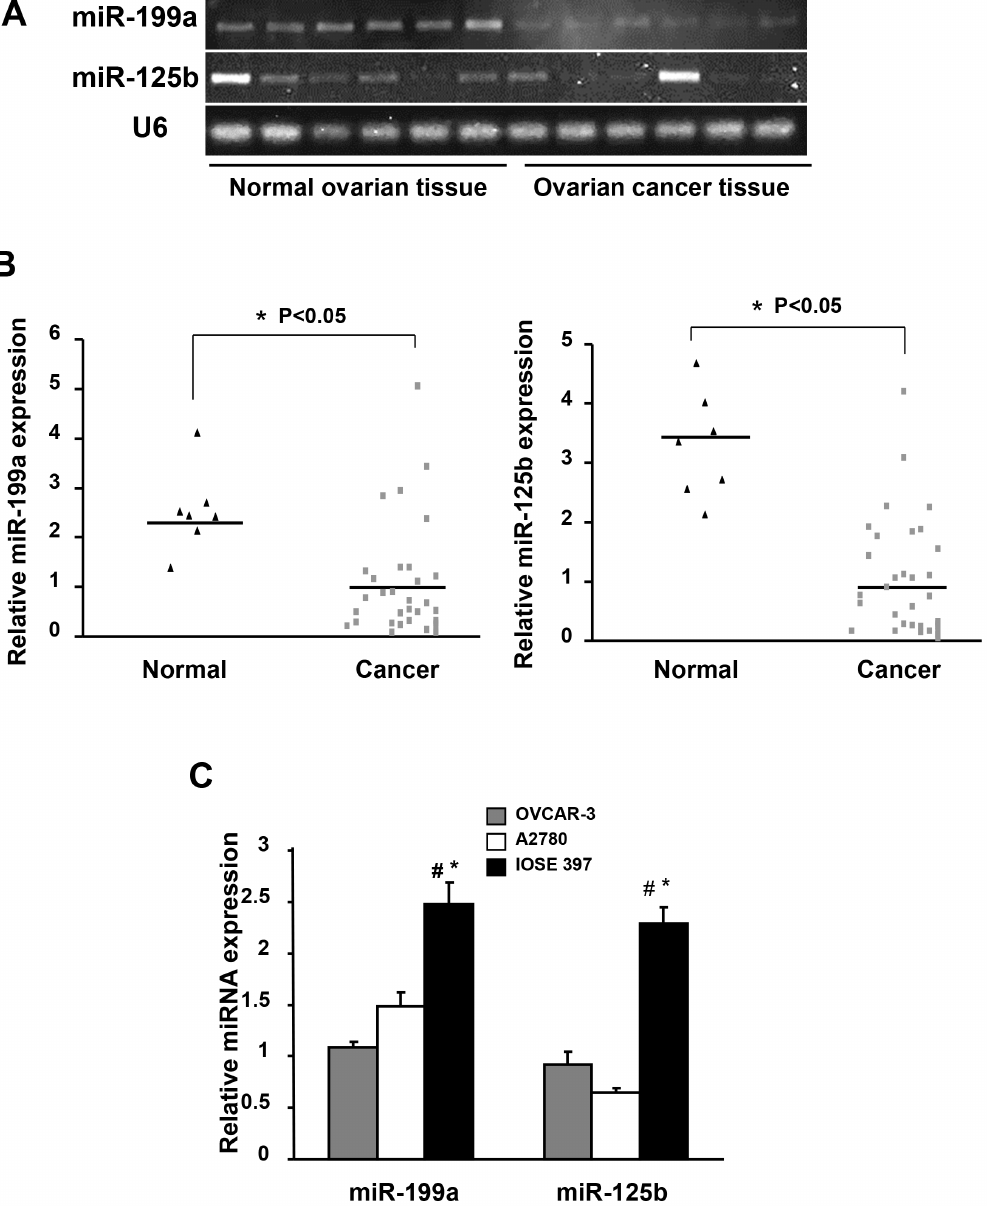
Figure 1. MiR-199a and miR-125b are down-regulated in ovarian cancer tissues and cells. (A) The expression levels of miR-199a and miR- 125b in human epithelial ovarian carcinoma tissues and normal ovarian tissues determined by RT-PCR. Total of 33 ovarian epithelial cancer tissues and 7 normal ovary tissues were analyzed. Representative samples (n=6 for each group) are shown. The expression level of U6 was used as loading control. (B) Taqman RT-PCR was performed to assess miR-125b and miR-199a expression levels using 33 ovarian cancer tissues and 7 normal tissues. The bar refers to the mean for each group. The values were normalized to the mean of cancer tissues. *Significantly different compared with that of control (P , 0.05). (C) The miR-199a and miR-125b expression levels were analyzed using Taqman qRT-PCR in ovarian cancer cell lines. Relative expression levels were represented as RQ using of 2 2 DD CT methods. Each data sample was normalized to the U6 expression level and that in OVCAR-3 cells. Mean 6 SE values were from three separate experiments. # Significantly different compared with OVCAR-3 (P , 0.05). *Significantly different compared with A2780 (P , 0.05).